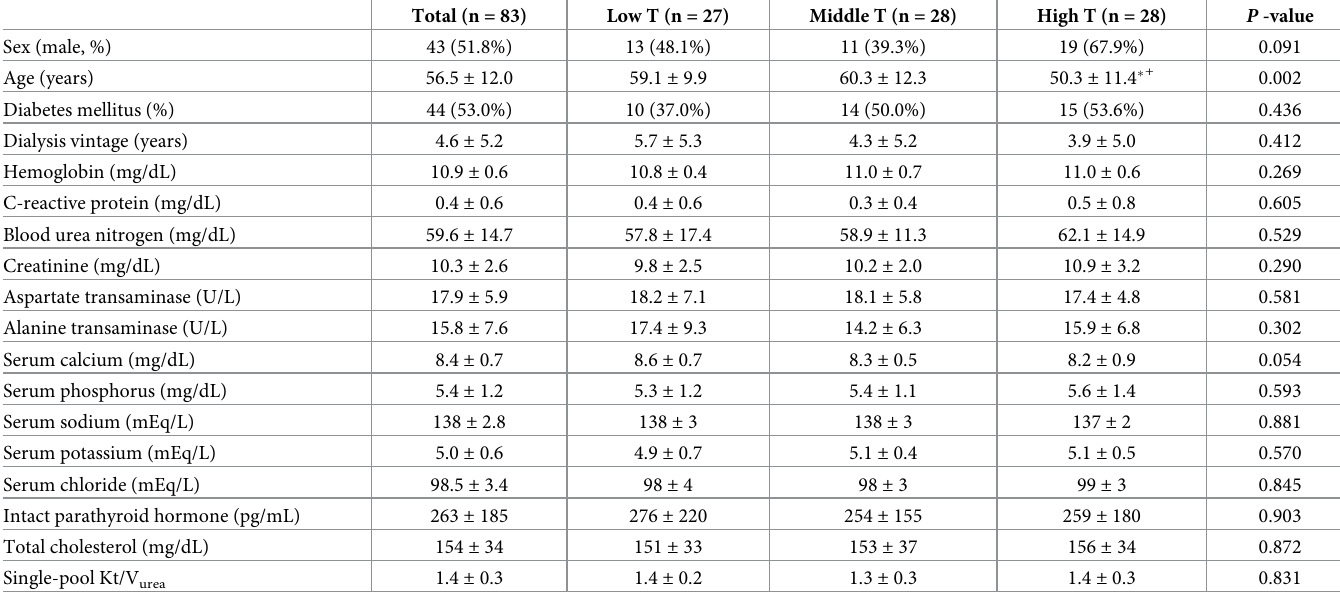
Table 1. Clinical characteristics of patients.